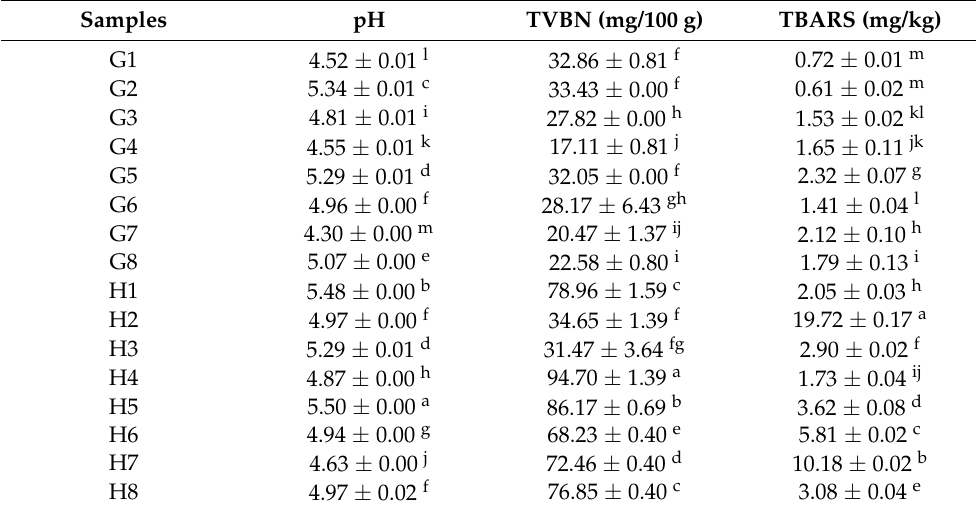
Table 2. The pH values and TVB-N and TBARS contents of Suanyu